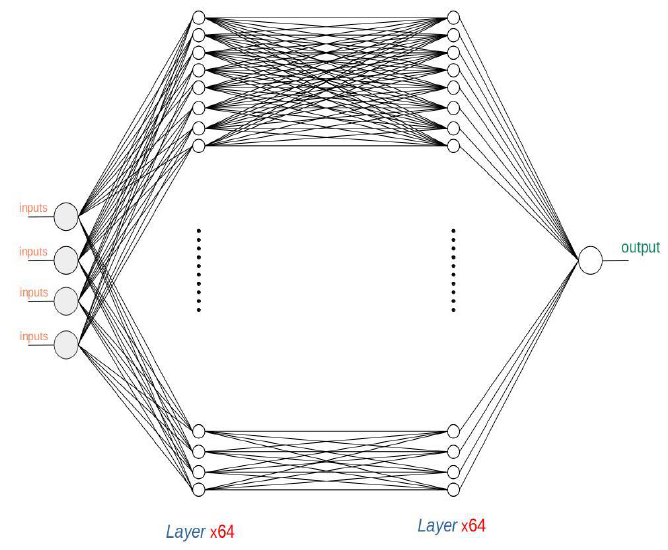
Figure 4. Deep Neural Network architecture. Prepared by the